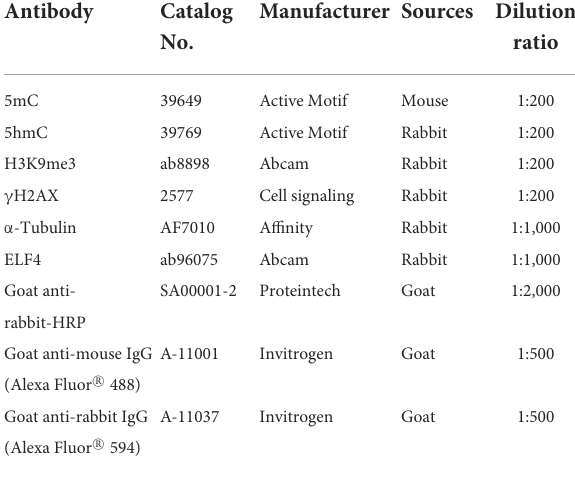
TABLE 2 Primers used in the qPCR analysis. Primer